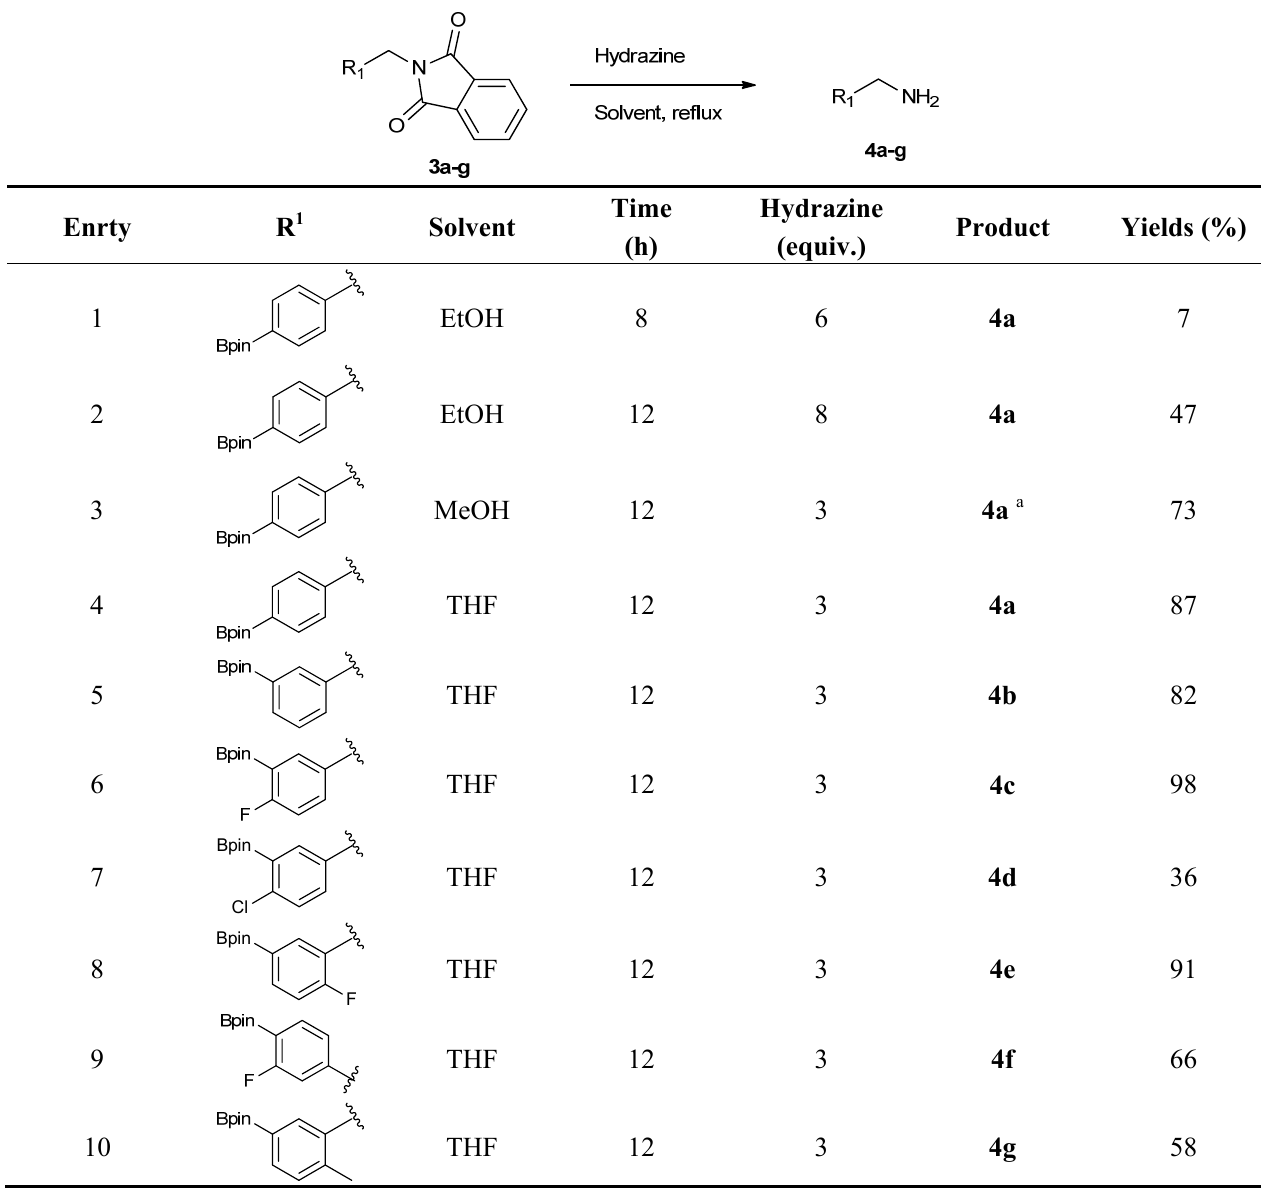
Table 3. Synthesis of aminomethylphenyl boronate